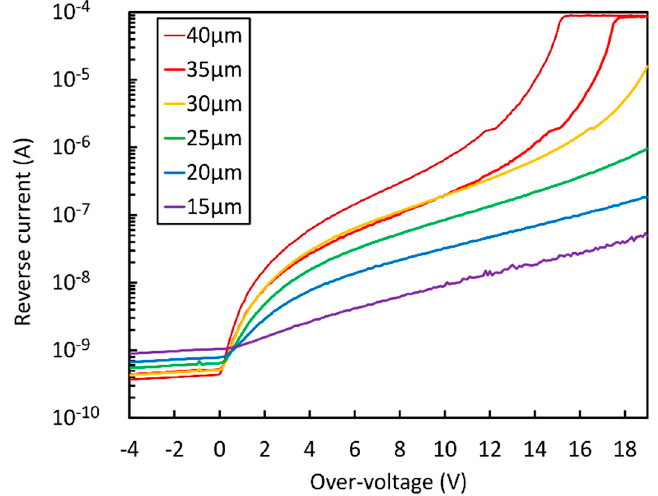
Figure 10. Reverse current as a function of the overvoltage for the different cell sizes of the NUV-HD SiPMs (from 15 µm to 40 µm).